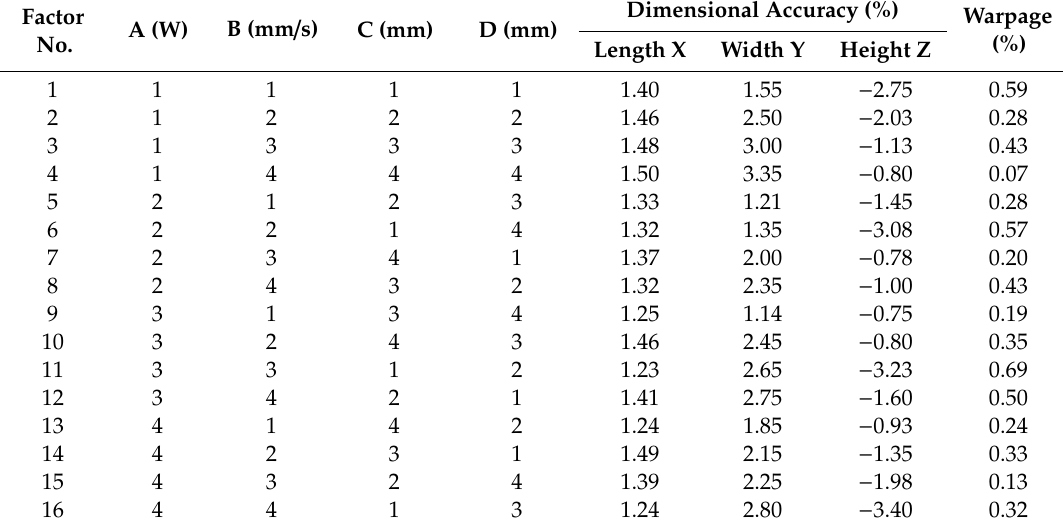
Table 4. Forming precision of orthogonal array designed specimens.